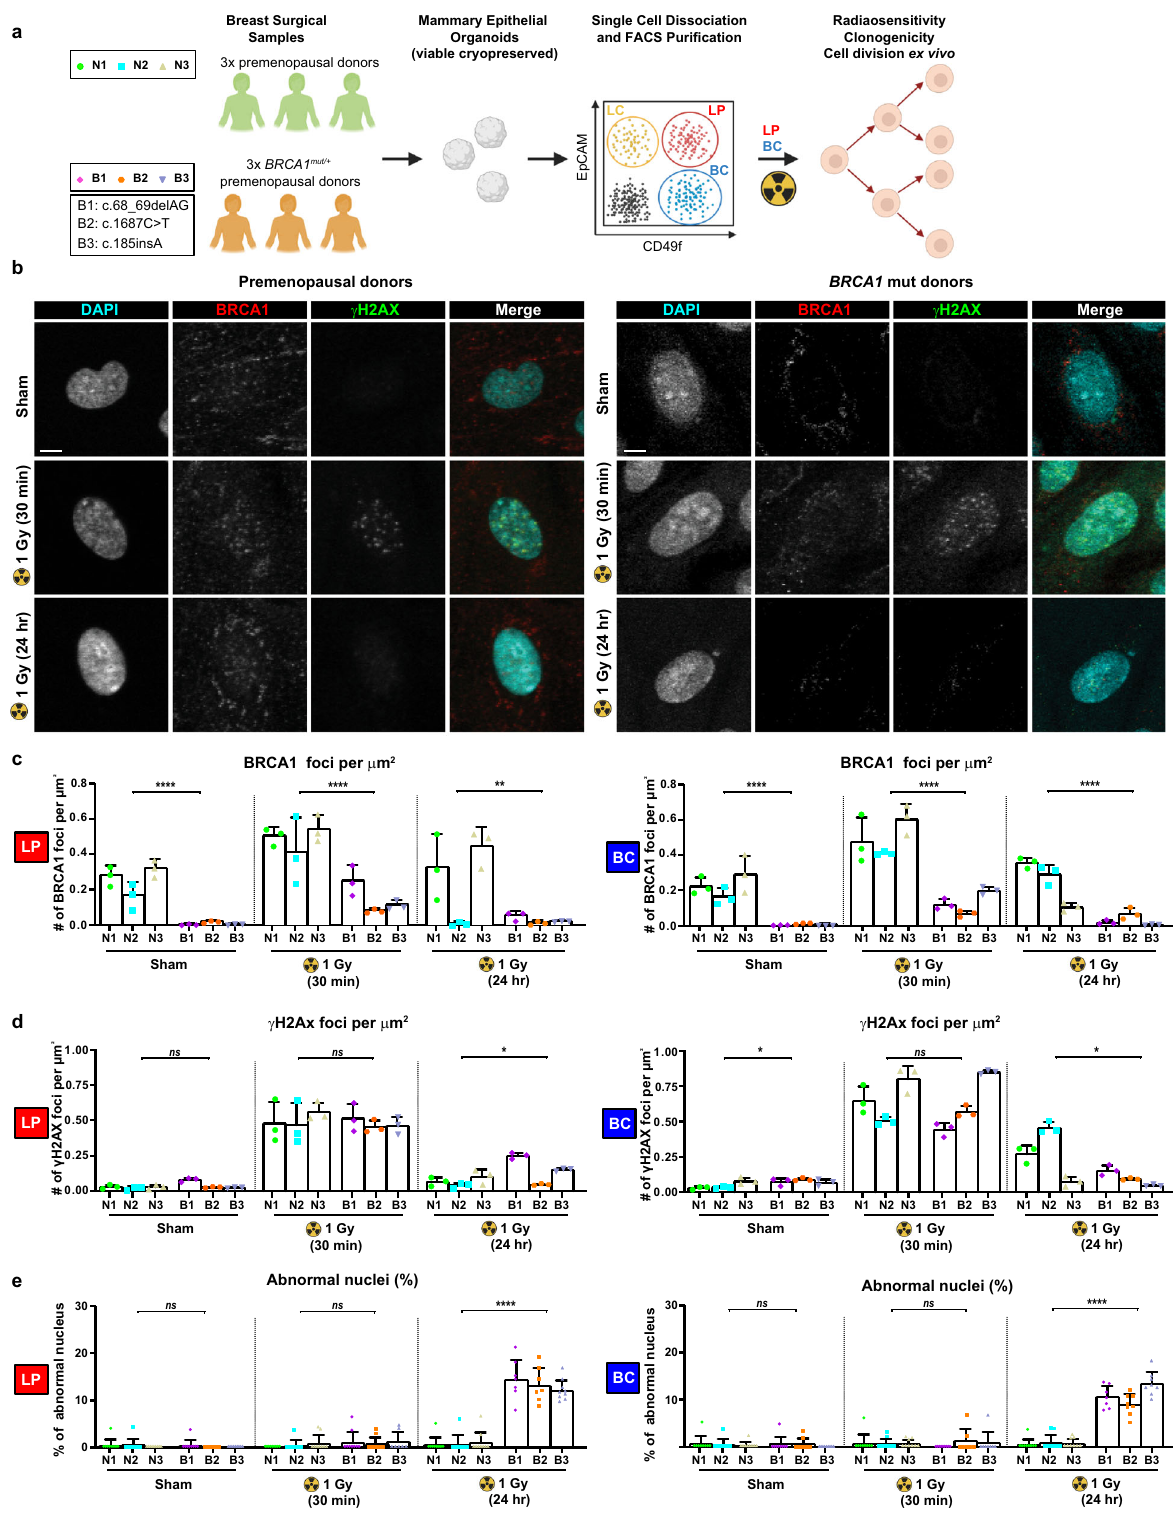
variants ( 185delAG/ + ;C61G/ + ;C64R/ + ;A1780E/ + ;5832insG ) and the VUS expressed signi fi cantly reduced levels of BRCA1 nuclear foci (Fig. 3b), similar to our results for the cells derived from the LPs and BCs isolated from the human BRCA1- mutant mammary tissues (Fig. 1b). However, three MCF10A cell lines that encode BRCA1 variants classi fi ed as pathogenic or likely pathogenic ( R71G/ + ;R1835X/ + ;W1837R/ + ) expressed normal levels of